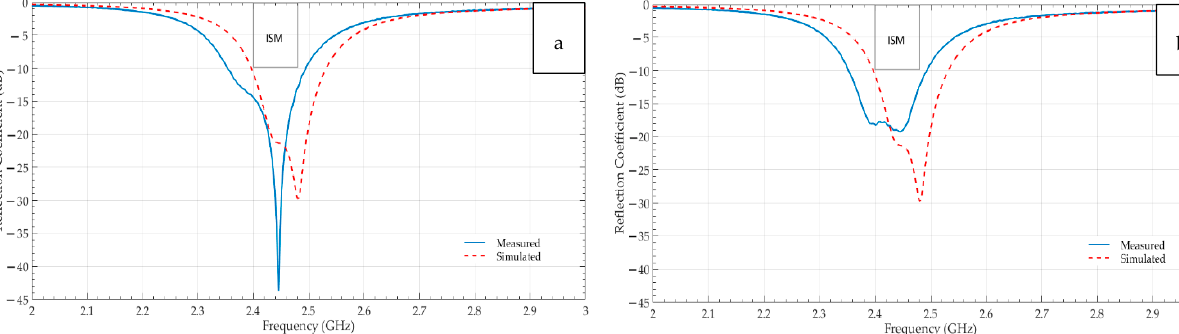
Figure 9. Simulated and measured reflection coefficients-S11 of ( a ) non-perforated KIEL based RRMPA ( b ) perforated KIEL based RRMPA.